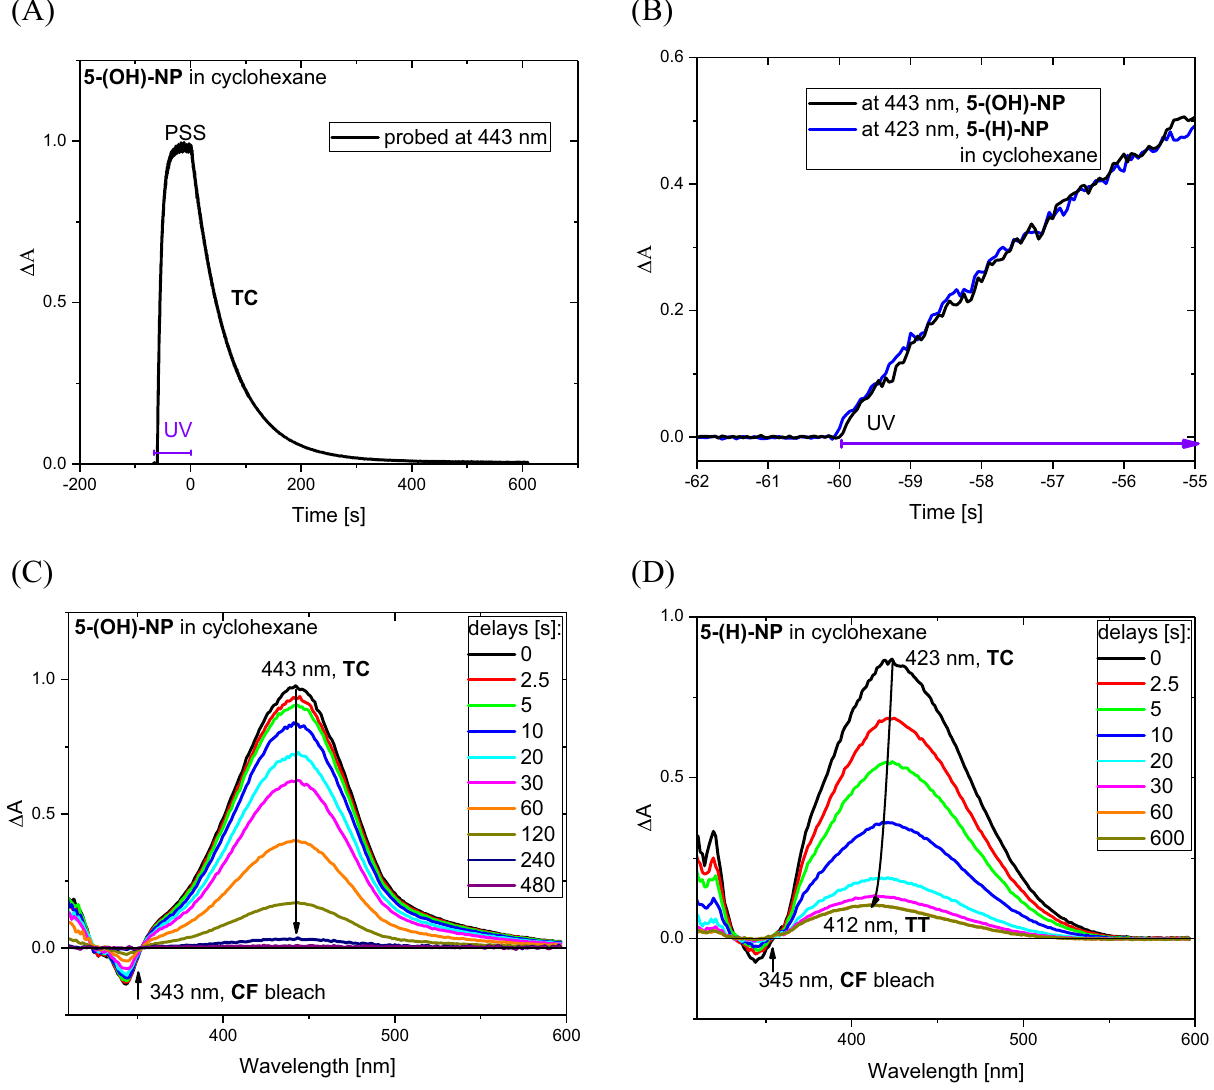
Figure 3. ( A ) Changes in absorption at probe 443 nm caused by UV irradiation. (λ = 340 nm, 4 mW/cm 2 ) of 5-(OH)-NP in cyclohexane at 21 °C. ( B ) The initial rise in absorption upon switching on UV irradiation for two solutions 5-(OH)-NP and 5-(H)-NP in cyclohexane prepared with the same absorption (A(340 nm, 1 cm) = 0.32). ( C , D ) Evolution of ΔA spectra after ceasing UV irradiation at t = 0 s for 5-(OH)-NP and 5-(H)- NP , respectively.